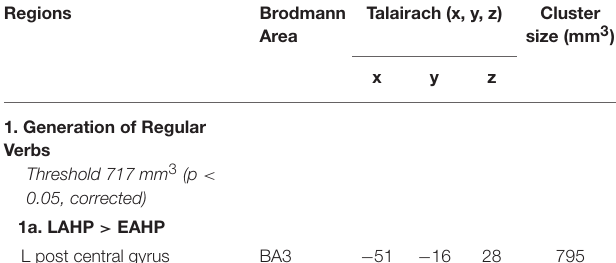
TABLE 3 | Regions activated by the EAHP vs. LAHP groups in the (1) Generate Regular Past Tense, (2) Generate Irregular Past Tense, and (3) Contrast between Irregular and Regular Tense generation tasks,